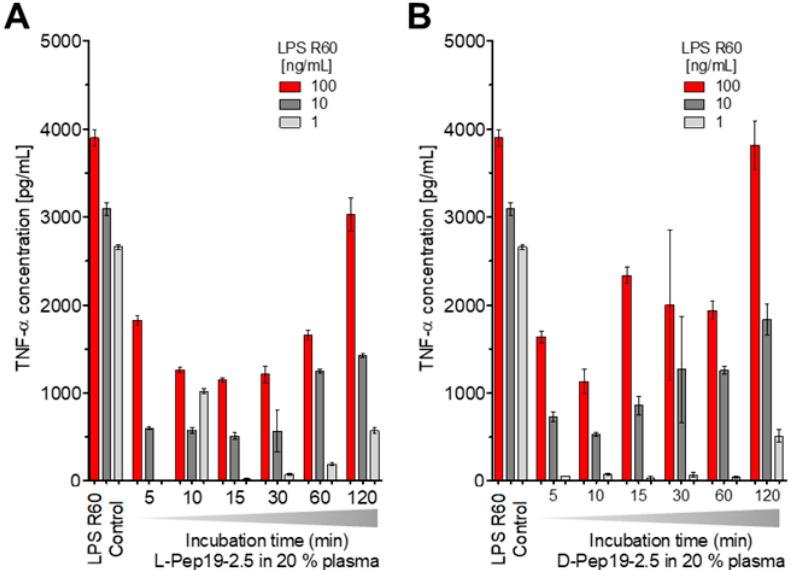
Figure 7. LPS-induced secretion of TNF α by human mononuclear cells in the presence of Pep19-2.5 ((LPS):(Pep19-2.5) 1:10 weight %) incubated before addition at 37 °C for different times in human plasma (20%). (A) Data for the L-configured peptide, (B) Data for the D-configured peptide which is insensitive to the action of proteases. Mean values and standard deviations due to the determination of TNF α in duplicate.